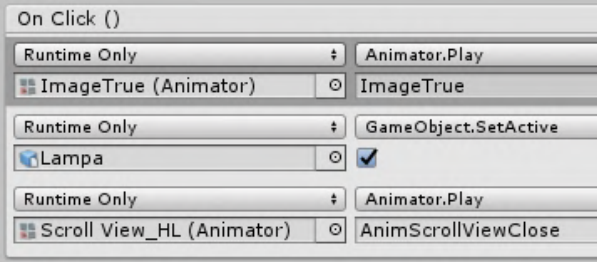
Figure 10: Button settings with correct answer.